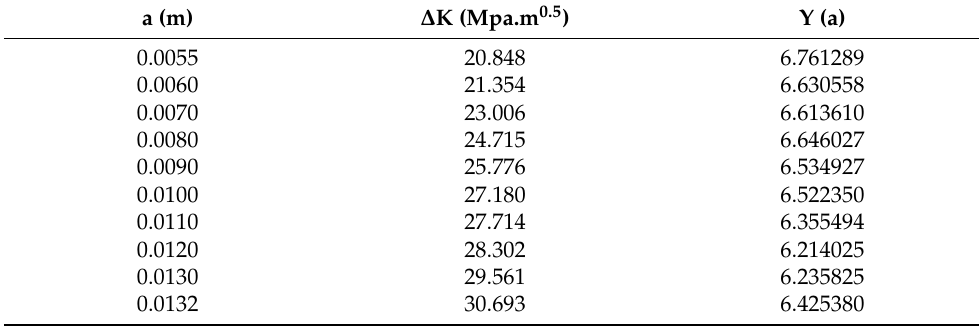
Table A1. Obtained geometry function for the investigated pipeline based on stress range intensity factor calculated from FEM results adopted from